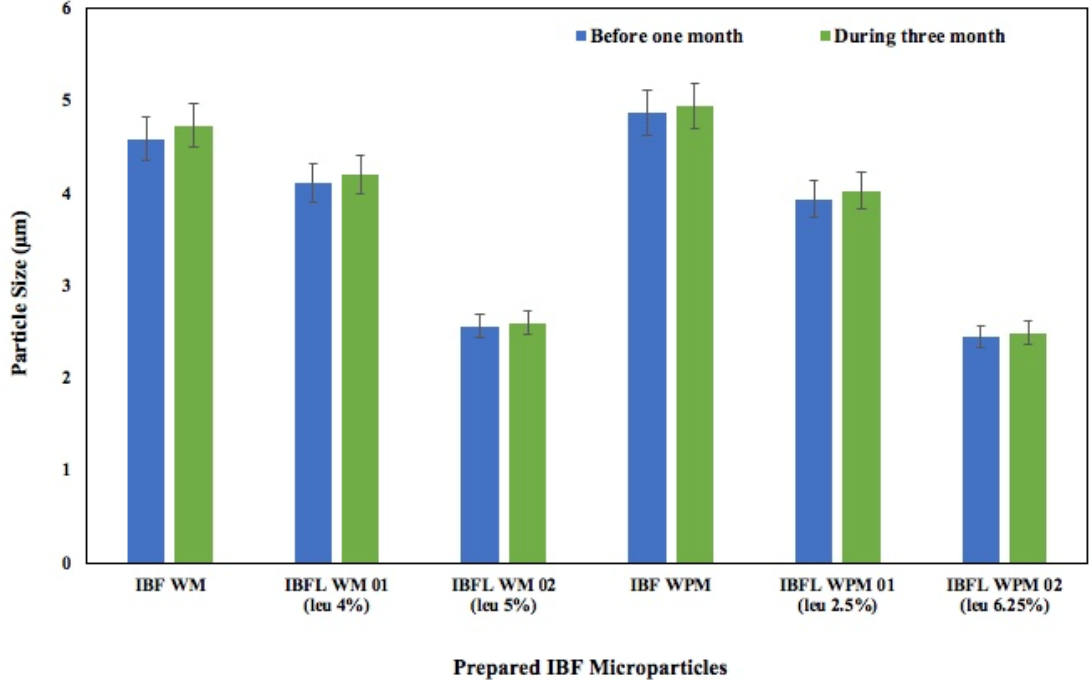
Figure 1. Prepared IBF particle sizes before and after one month of short storage (Mean ± SD, n = 3). 3.3. Surface Morphology by Scanning Electron Microscopy (SEM) The morphological structure of original ibuprofen, micronized IBF and developed DPI formulations was obtained by SEM imaging. The original ibuprofen particles appeared as needle-like shapes with sharp edges and slightly rough surface (Figure 2: Original IBF). After milling, inhalable sized particles (<5 µ m) were small with less irregularities (Figure 2: milled microparticle) along with spherical-shaped smaller agglomerates, which were found to be smaller than the original drug particles. SEM images also confirmed the drug particle size between 0.4 to 5 µ m. However, DPI formulations appeared as a physical mixture of large carrier lactose in which micronized IBF particles were attached to the surface of large carrier lactose particles (Figure